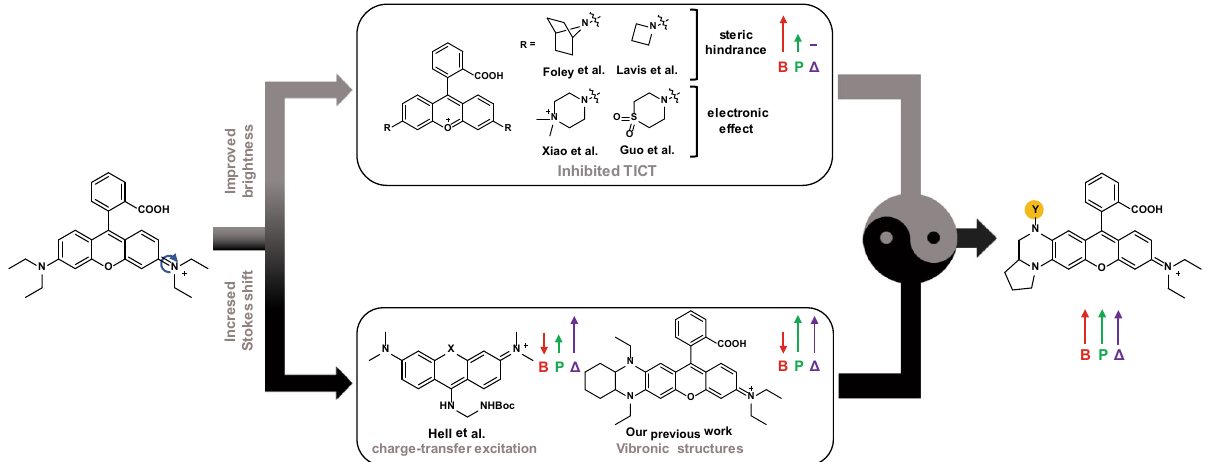
Fig. 1 The conventional and new strategies to improve the brightness, photostability, and Stokes shift. In the previous work, brightness, photostability, and Stokes shift can be partially enhanced by inhibiting TICT, generating vibronic structures, or inducing charge-transfer excitation. A new strategy that unites the strength of TICT inhibition and vibronic structure is proposed to simultaneously increase the brightness, photostability, and Stokes shift. Y (orange circle) denotes the positions used to introduce EWGs to tune electron density. B, P, and Δ represent brightness, photostability, and Stokes shift